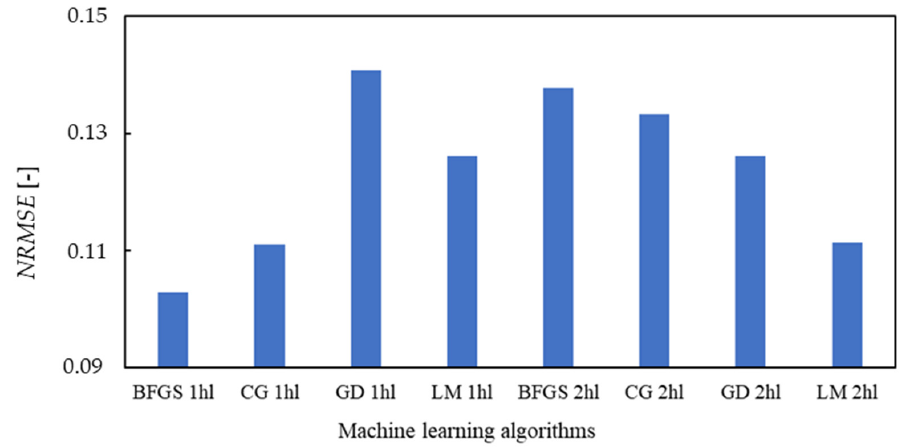
Figure 16. Comparison of models for predicting the pull-off strength of the surface layer f h due to the value of NRMSE .